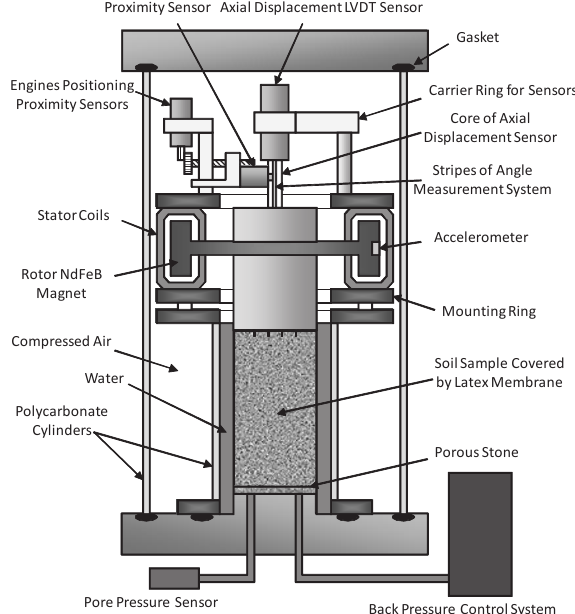
Figure 3: RC/TS apparatus scheme. Fig. 3. RC/TS apparatus scheme.